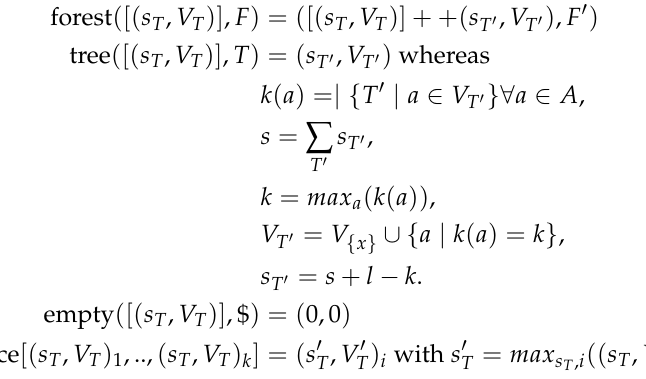
Figure A1. Scoring algebra for the Fitch/Hartigan version of the small parsimony problem.